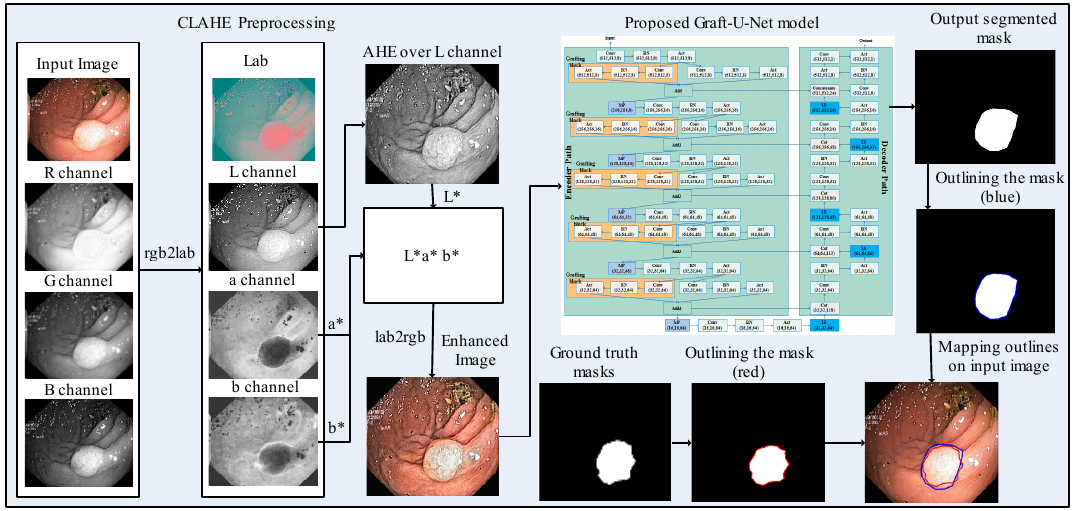
Figure 1. Block diagram of the proposed method for polyp segmentation.